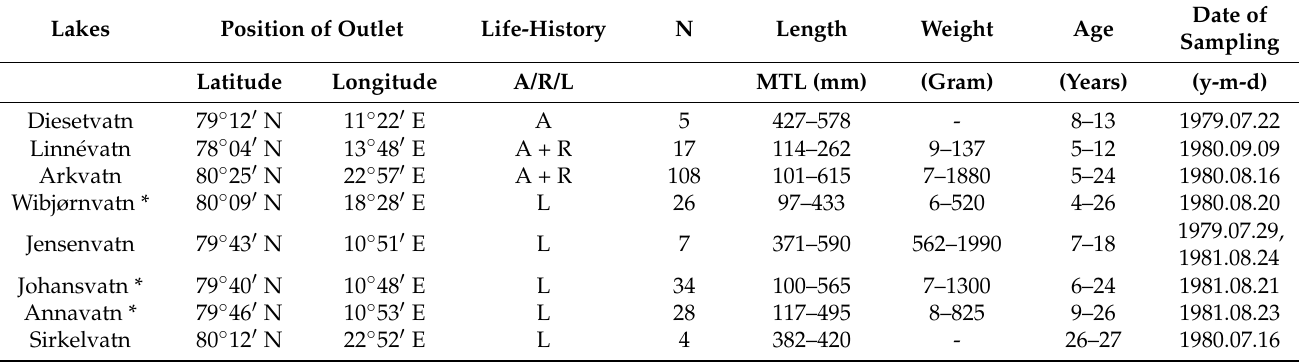
Table 1. Geographic position of lakes surveyed in Svalbard, and the size and age range of the samples of Arctic char analyzed. While the char from Lakes Diesetvatn and Sirkelvatn were collected with seine and hook, respectively, the remainder were caught with multiple mesh size gillnets. The life-history abbreviations refer to anadromous (A), resident (R), and landlocked (L)